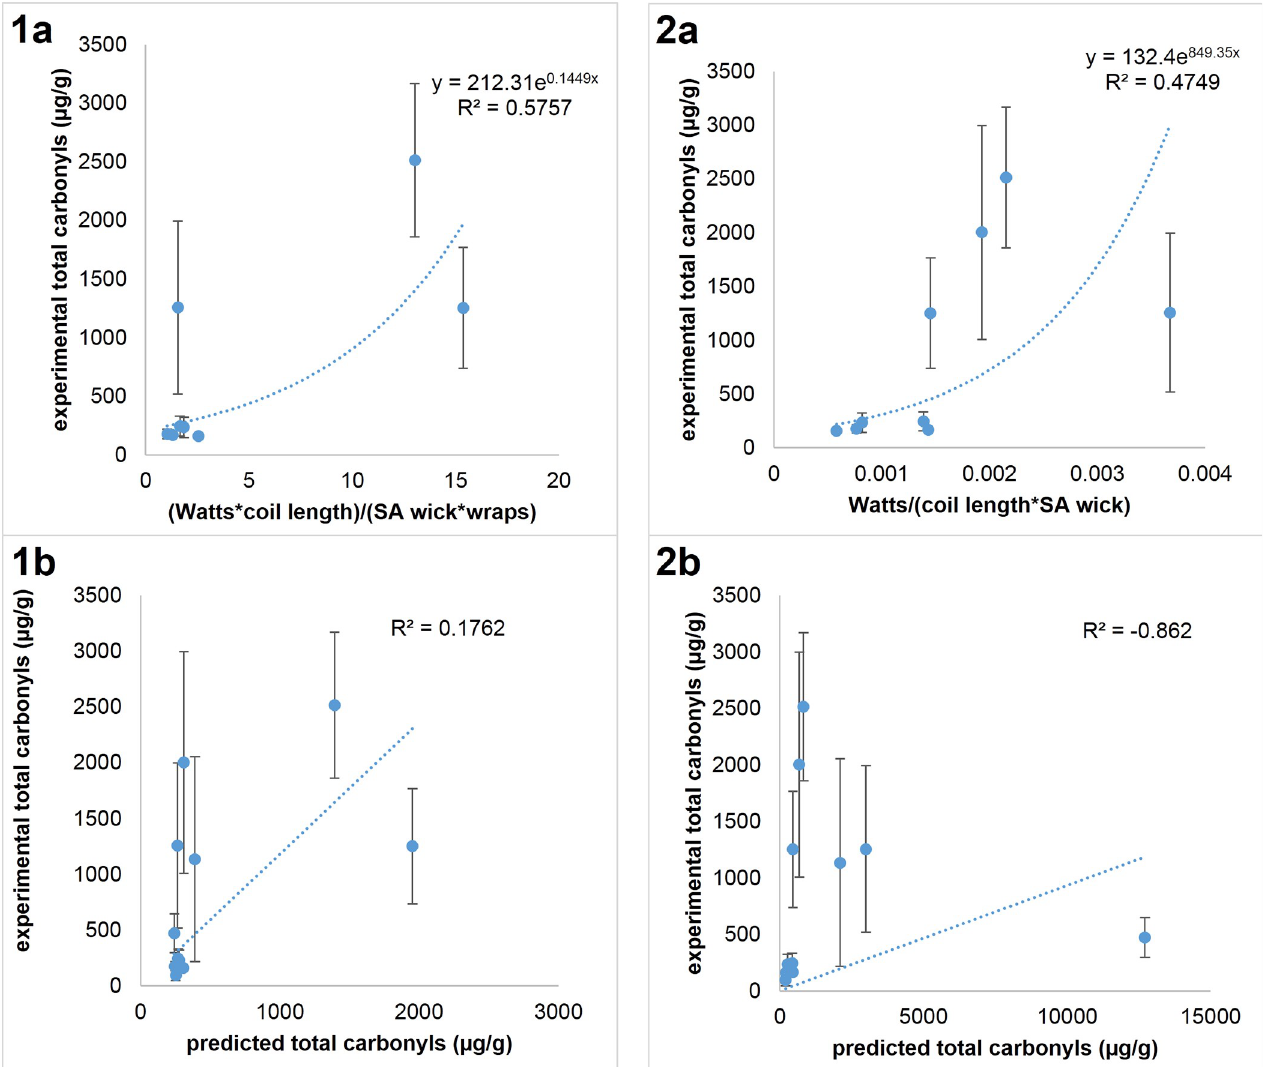
Fig 5. Analyzing alternative models as predictors of measured toxins. Graph 1a shows the regression analysis of EC1-9 using (Watts � coil length)/(SA wick � wraps). Graph 1b displays a weak predictability (R 2 = 0.1762) of EC1-12 using the equation of the regression analysis from 1a . Graph 2a shows the regression analysis of EC1-9 using Watts/(coil length � SA wick). Graph 2b displays a weak predictability (R 2 = -0.862) of EC1-12 using the equation of the regression analysis from 2a